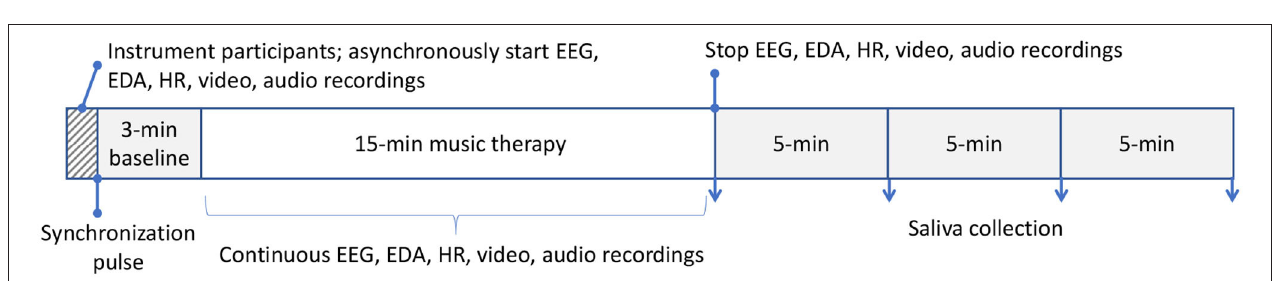
FIGURE 1 | Experimental setup for simultaneous EEG recording from children and their parents. For clarity, wired connections between data acquisition computer and sensors are not shown.